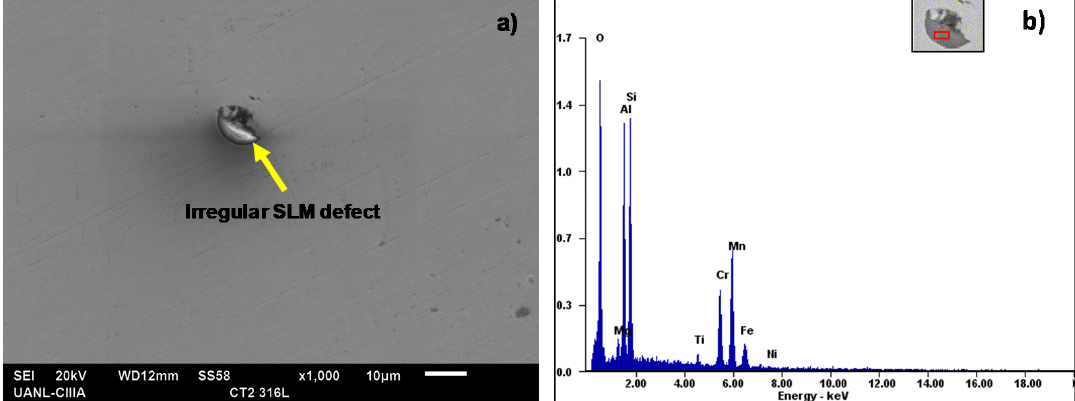
Figure 6. ( a ) SLM inclusion found on the polished surface and ( b ) its EDS chemical composition showing high contents of